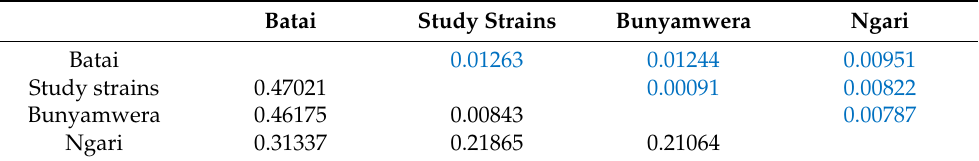
Table 2. Estimates of net genetic distance between groups.